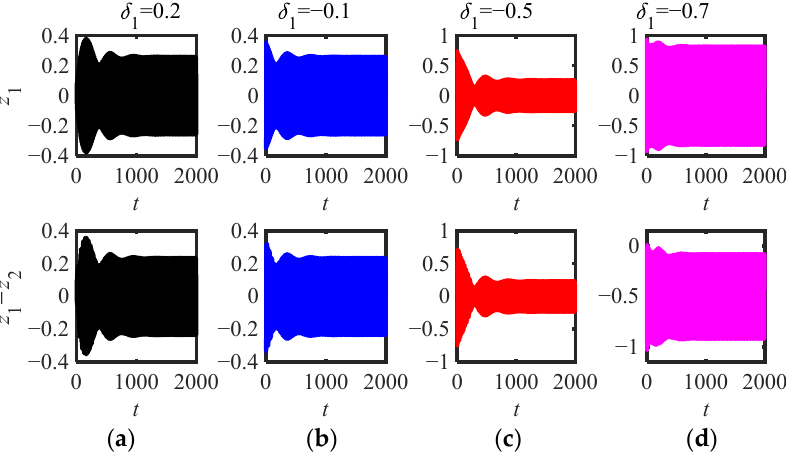
Figure 16. Time-domain response of (5) (parameters in Figure 11b m 2 = 4, μ = 1.9, κ = 0.1): ( a ) δ 1 = 0.2, ( b ) δ 1 = − 0.1, ( c ) δ 1 = − 0.5, ( d ) δ 1 = − 0.7. For S.2: from Figure 10a,b in Section 4.2 and Figure 12a,b in Section 4.3, we can see that it is not easy to maintain multiple solutions, and the stability of the three equilibrium points is the same as that of S.1 (Figure 11b). To verify the special case of S.2, that is, whether the inerter can replace the mass function of traditional NES, we selected three groups of parameter schemes for comparison: T 1 ( μ = 2, m 2 = 0, b n = 0.4), T 2 ( b n = 0, m 2 = 0.4), T 3 ( μ = 1.9, m 2 = 0, b n = 0.4) and the other parameters are selected when κ = 1.1 in Figure 12a. Figure 17a,b, and c show the phase diagrams of the three parameter schemes of the original system (6). The initial interference selection method is the same as that of S.1, and the four initial interferences ( δ 1 ) are ( − 0.01, 0.0, 8, 0.14, 0.3). Figure 18a,b show the displacement responses ( z 1 , z 1 - z 2 ) of T 1 and T 2 when the interference is − 0.01 and 0.14, respectively. Figure 18c,d show the displacement ( z 1 , z 1 - z 2 ) response of T 3 and T 2 when the interference is − 0.01 and 0.14, respectively.